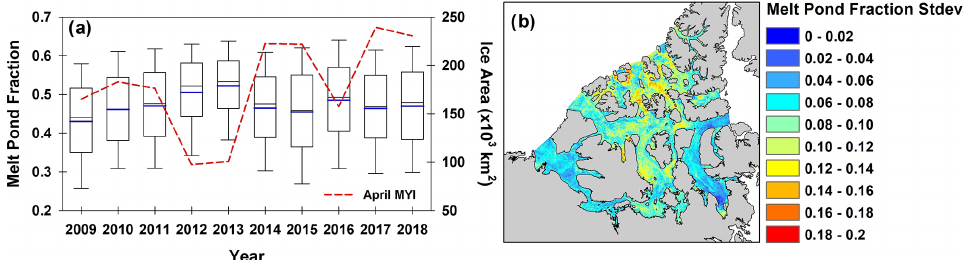
Figure 5. Boxplot time series of RADARSAT-2 peak melt pond fraction ( f pk ) and mean April multi-year ice (MYI) area in the Canadian Arctic Archipelago for 2009–2018. The solid blue line represents the mean (a) . Spatial distribution of the RADARSAT-2 f pk standard deviation from 2009–2018 (b) .